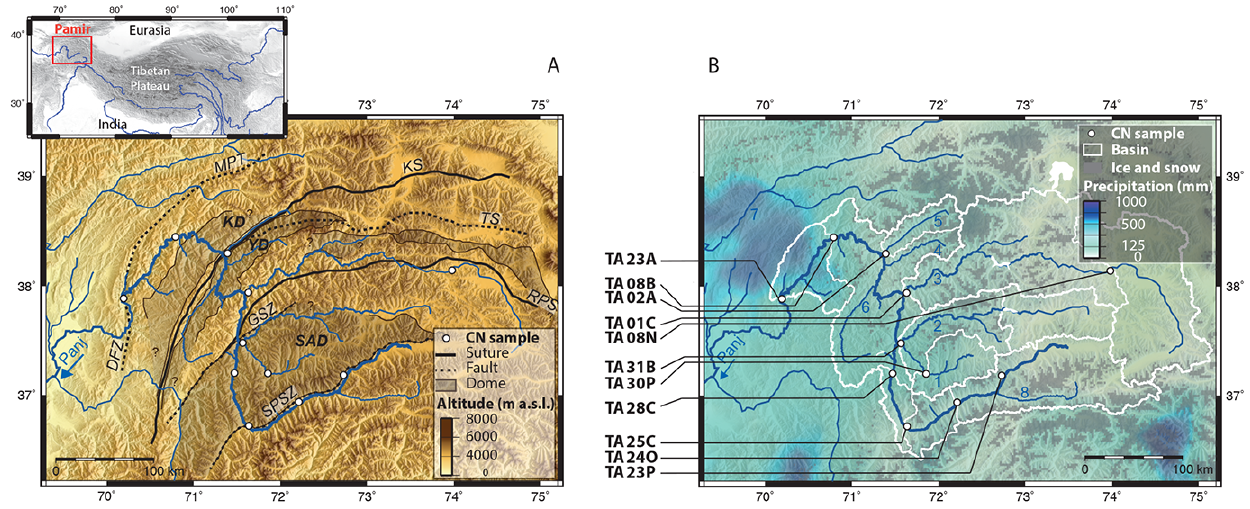
Figure 1. Regional setting of the Panj River system and sample locations (CN: cosmogenic nuclide; a.s.l.: above sea level). Panel ( a ): topography and main tectonic structures (DFZ: Darvaz Fault zone; MPT: main Pamir Thrust; KS: Kunlun suture; TS: Tanymas suture; RPS: Rushan-Psart suture; GSZ: Gunt shear zone; SPSZ: southern Pamir shear zone; KD: Kurgovat Dome; YD: Yazgulom Dome; SAD: Shakhdara and Alichur Dome; ASTER GDEM 30m resolution, modified according to, e.g., Schwab et al., 2004; Stübner et al., 2013). Panel ( b ): sample locations along the Panj River network with related upstream drainage basins (tributaries represent the following: 1 – Shakhdara; 2 – Gunt; 3 – Bartang; 4 – Yazgulom; 5 – Vanj; 6 – Shiva; 7 – Vakhsh; 8 – Wakhan). The climate is shown by the distribution of annual